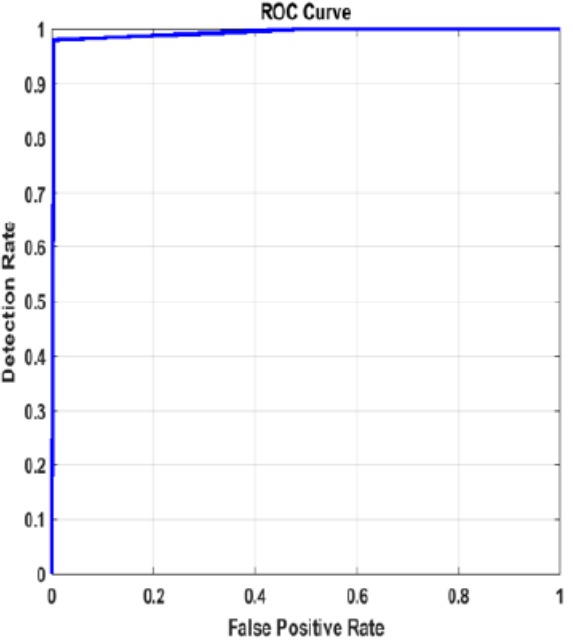
Figure 11. ROC curve for InceptionResnetv2 model with image SR using dataset #2.